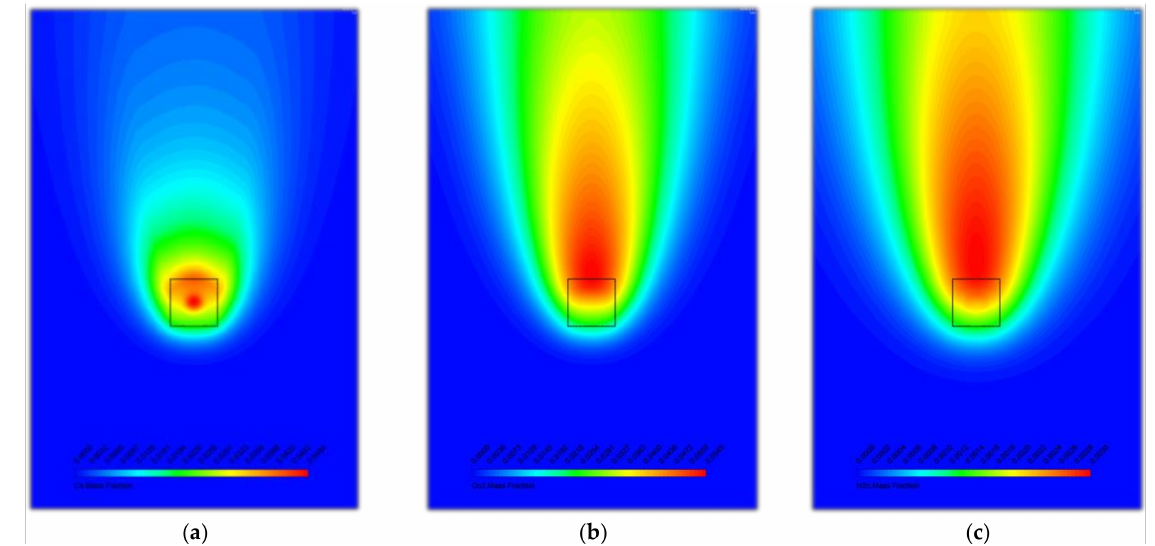
Figure 12. Mass fraction of ( a ) CO, (b) CO 2 and ( c ) H 2 O, at t = 50 s; maximum values: ( a ) 0.0484, ( b ) 0.0545 and ( c ) 0.003.